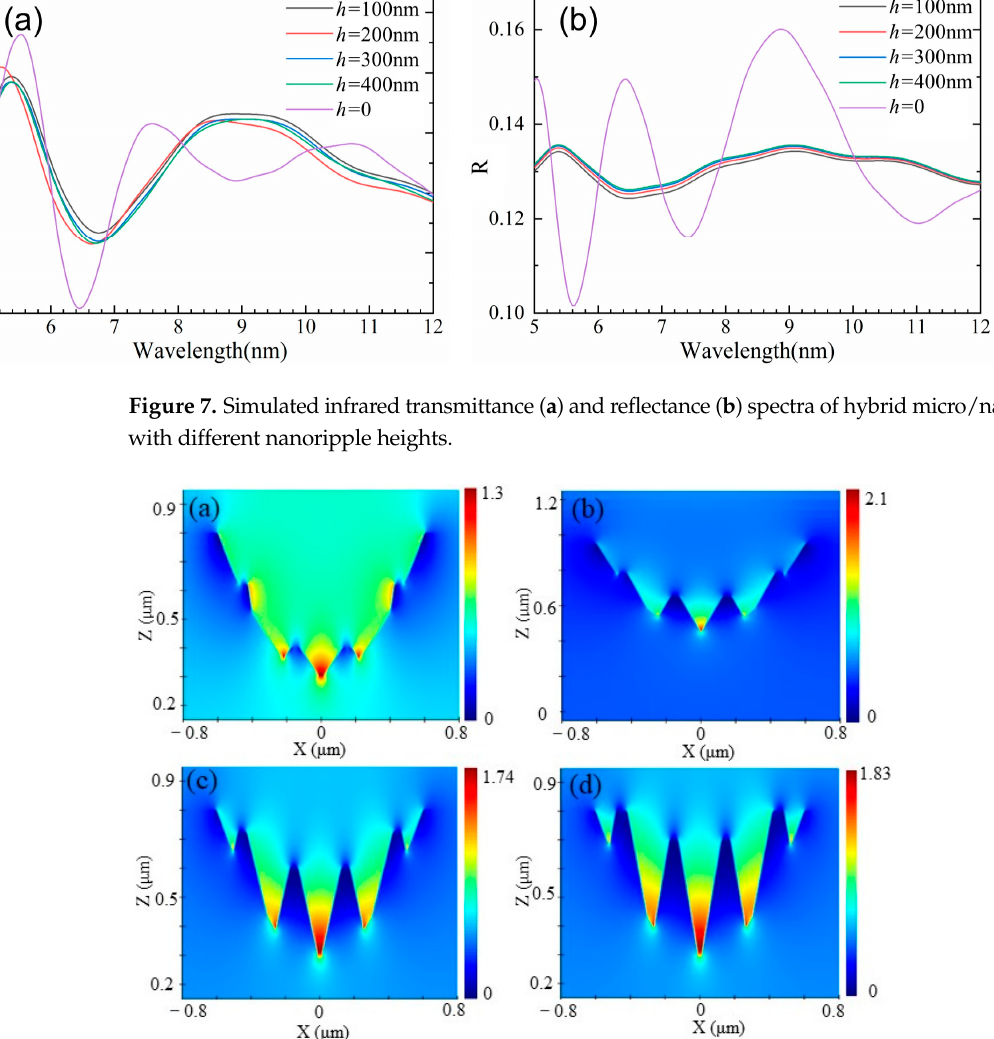
Figure 8. Light field distribution of the hybrid micro/nanostructure with heights of 100 nm ( a ), 200 nm ( b ), 300 nm ( c ), and 400 nm ( d ).